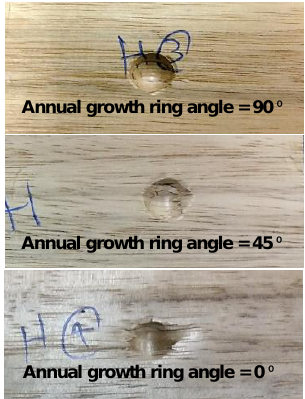
Figure 5. Fibre deformations in hardness samples with different annual growth ring orientations.